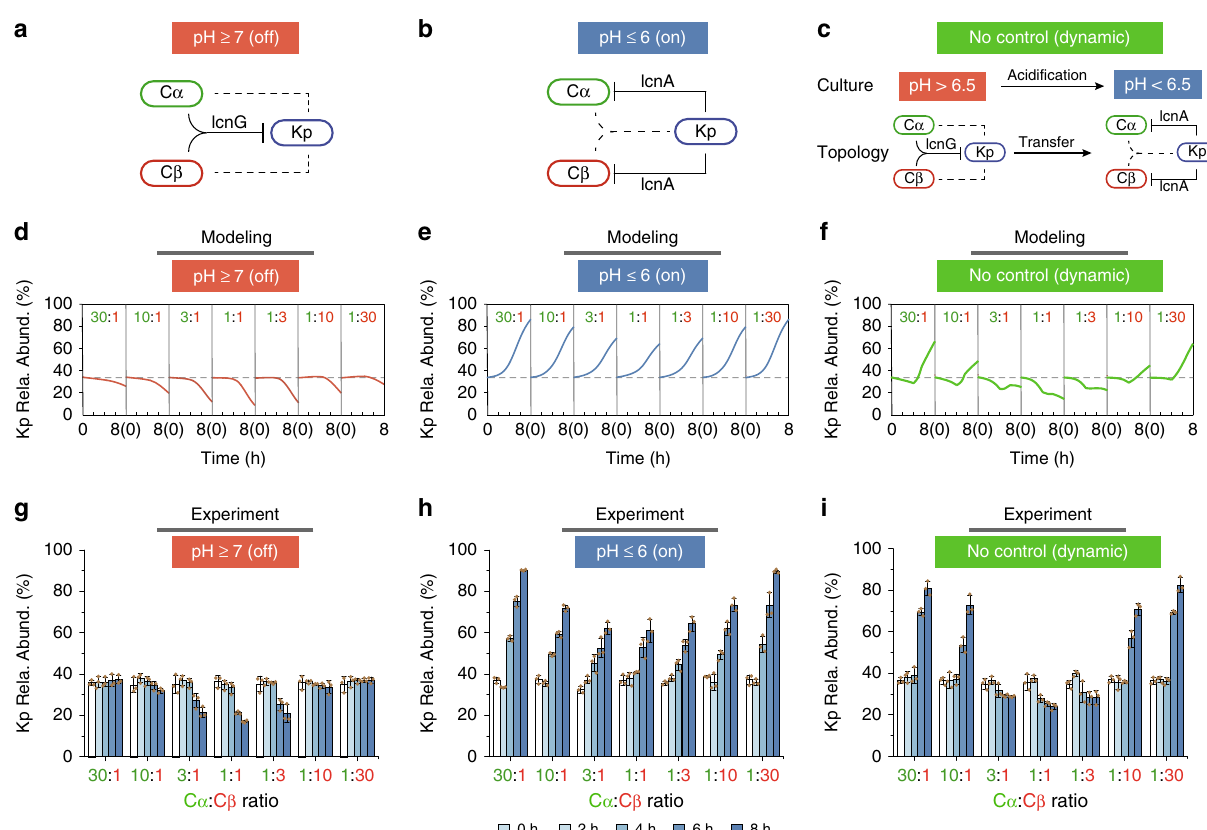
Fig. 6 Ecosystem dynamics jointly regulated by cooperation variations and competition variations. a – c Interaction topology of the C α -C β -Kp ecosystem in different pH settings. At pH ≥ 7 ( a ), the promoter P 774 remains inactive (i.e., ‘ Off ’ state), which abolishes Kp-to-C α /C β inhibition while allowing C α and C β to suppress Kp. At pH ≤ 6 ( b ), the promoter P 774 is active (i.e., ‘ On ’ state), leading to effective Kp-to-C α /C β inhibition but diminished C α /C β -to-Kp suppression. Where there is no pH control ( c ), the promoter dynamically transits from inactive to active (i.e., ‘ Dynamic ’ state) with pH reduction upon fermentation. As a result, the interaction network switches from C α /C β killing Kp to Kp killing C α /C β . d - i Model-predicted ( d – f ) and experimentally measured ( g – i ) temporal evolution of Kp abundance in three pH-de fi ned settings and under varied initial C α :C β partitions. Although C α :C β ratio was varied from 30:1 to 1:30, the total C α and C β concentration was kept at 2:1 ratio with the Kp concentration. Source Data available in the source data fi